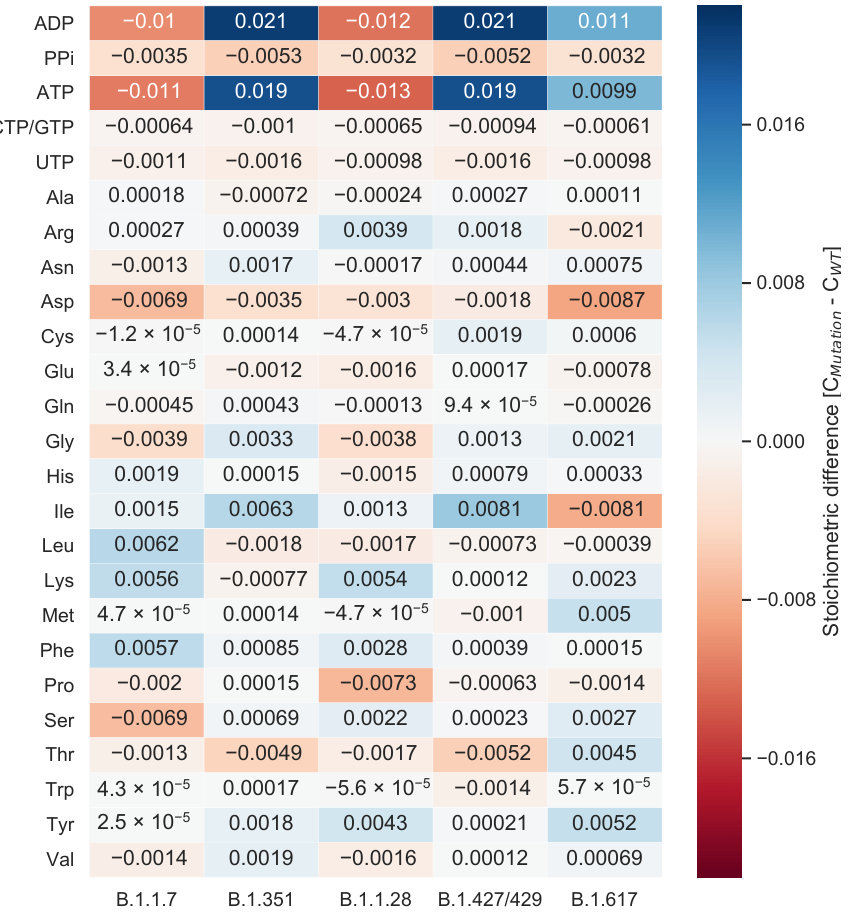
Figure 4. Difference of stoichiometric coefficients between wildtype (WT) and the individual muta- tions. The deviation between WT and the mean of the individual mutation variants was calculated. Higher stoichiometric coefficients in the mutation compared to the WT are indicated in blue, while lower stoichiometric coefficients are indicated in red. Based on similar sequence length for the muta- tion variants B.1.1.7 and B.1.1.28 and resulting similar total viral molar masses, a pattern emerges, which is most apparent for the stoichiometric coefficients of ATP and ADP. This pattern, however, is not present for all stoichiometric coefficients. The coefficient for L -serine, for example, is only decreased in the mutation variant B.1.1.7 based on two mutations in two structural proteins. Overall, the deviations from the WT are very